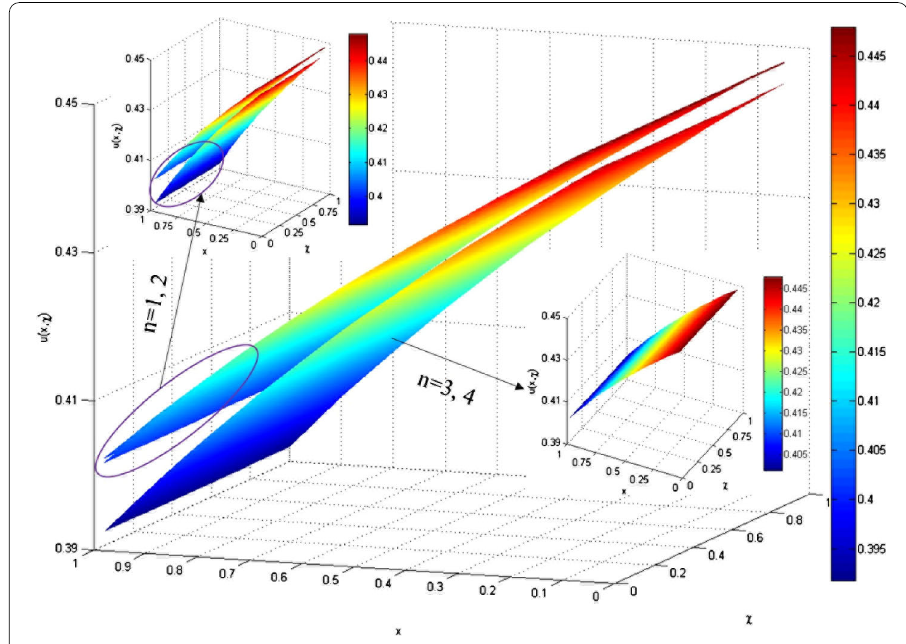
Figure 1 Numerical solution of the anomalous diffusion equation (22) as a function of time χ and space x for c = 0.5, ε = 0.8, (cid:4) = 0.5, θ = 0.3, ϑ = 0.2, n =